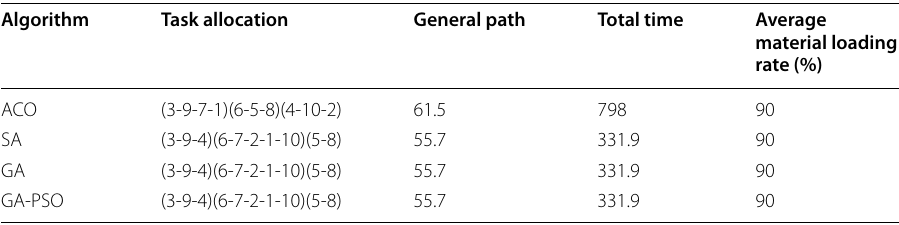
Table 3 Details of the optimal solutions of the first experiment Algorithm Task allocation General